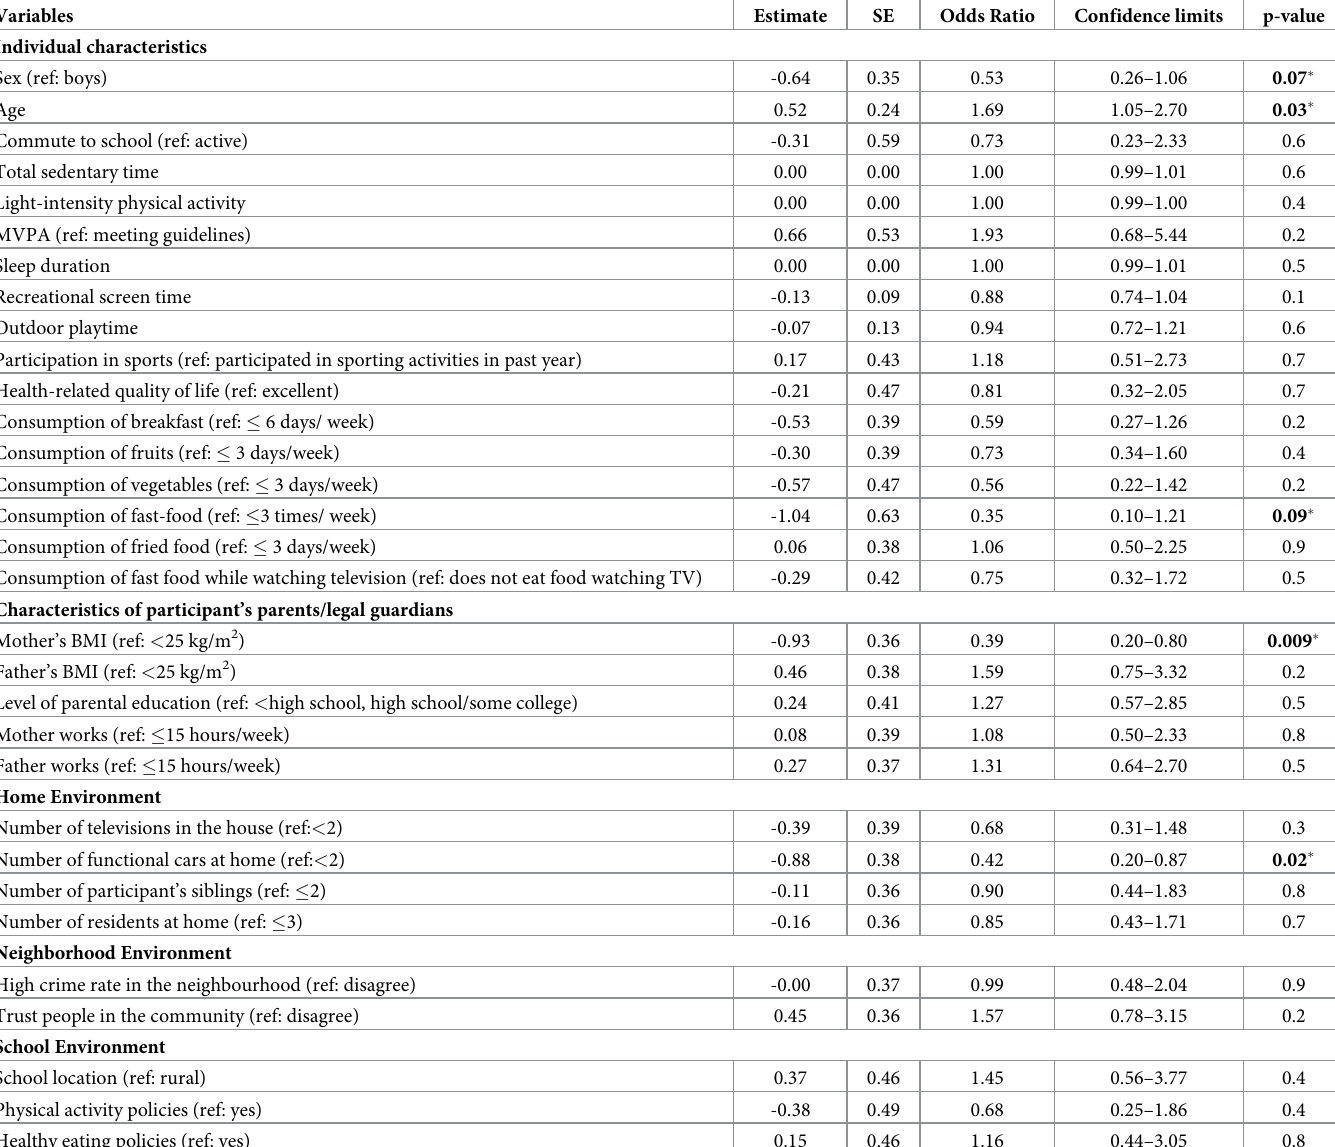
Table 4. Univariate correlates of